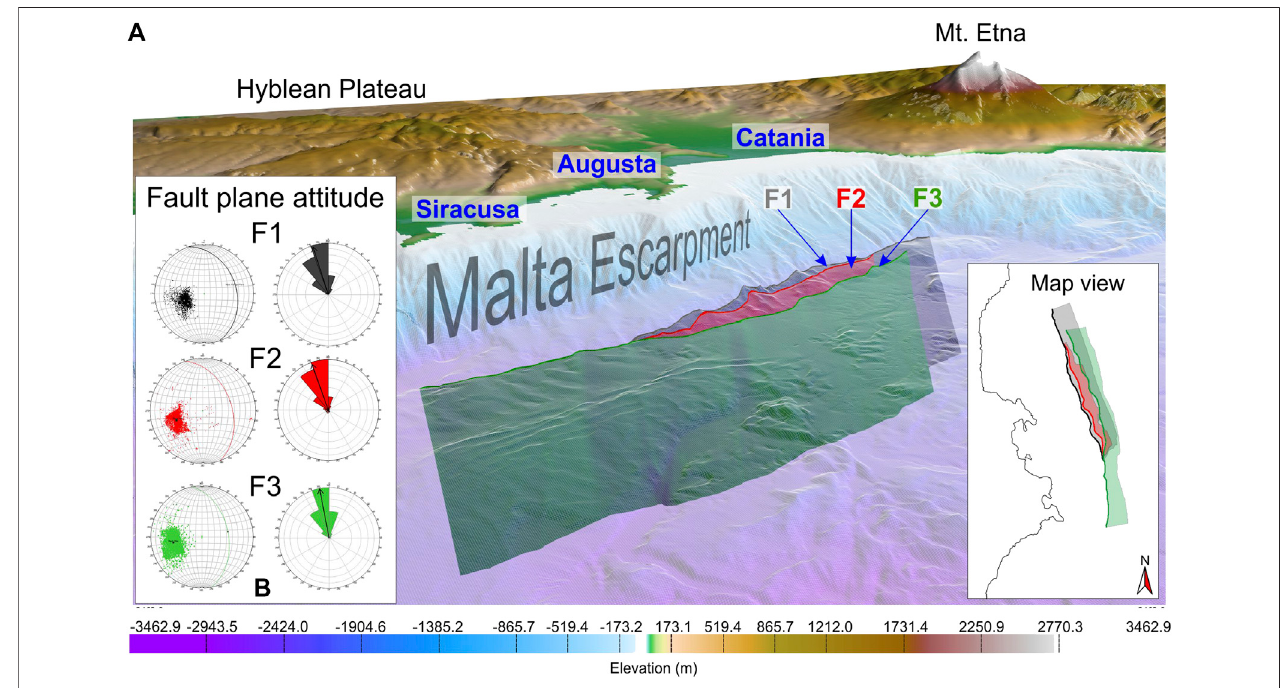
FIGURE 7 | (A) 2½D fault surfaces (perspective view from the SE) modeled according to reference lines (fault traces) picked along the seismic dataset (see Supplementary Figure 1 for the work fl ow) and related attitude in the 3D environment (B) .